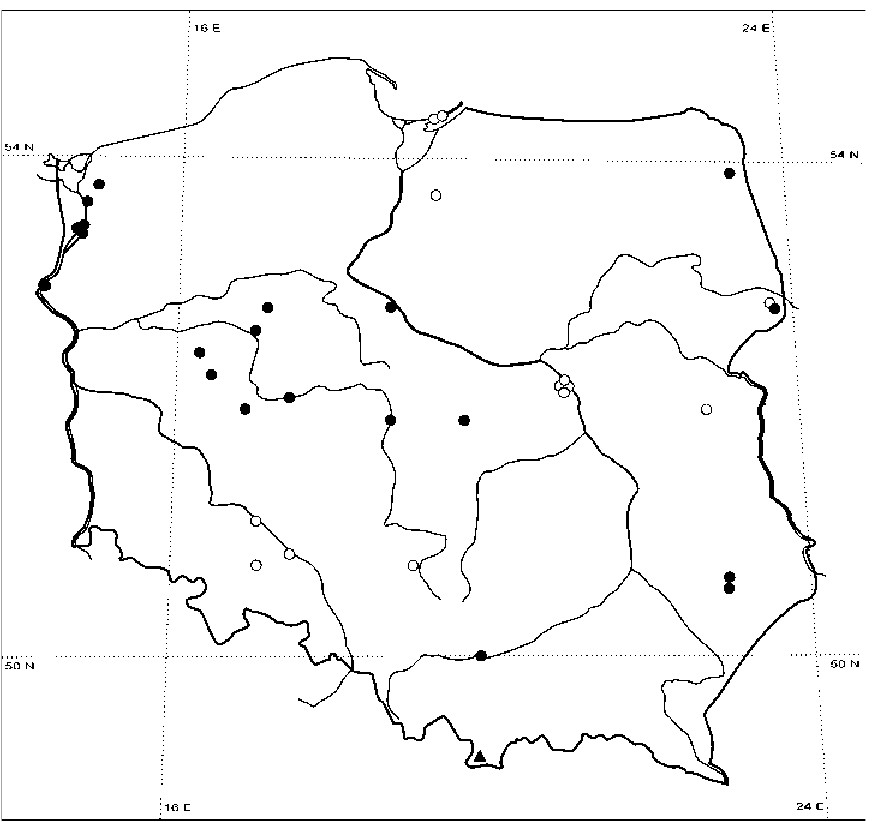
Fig. 2. Distribution of Psathyrella conopilus in Poland; white circle – localities reported before 1945 (some of them may be doubtful), black circle – after 1945, black triangle – new